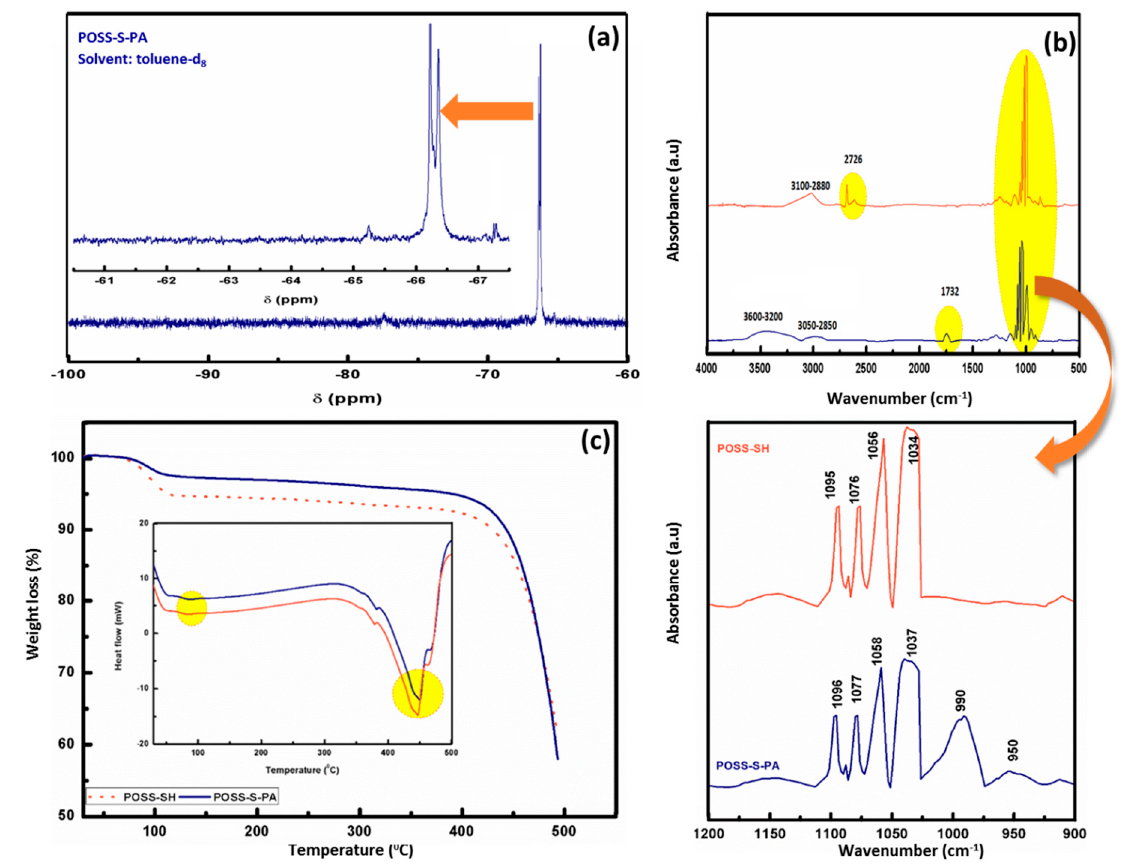
Figure 3. ( a ) 29 Si-NMR spectrum of POSS-S-PA; ( b ) FT-IR spectra of POSS-SH and POSS-S-PA; ( c ) TG-DTA thermogram of POSS-SH and POSS-S-PA. Table 1. Peak positions and its corresponding assignments of POSS-SH and